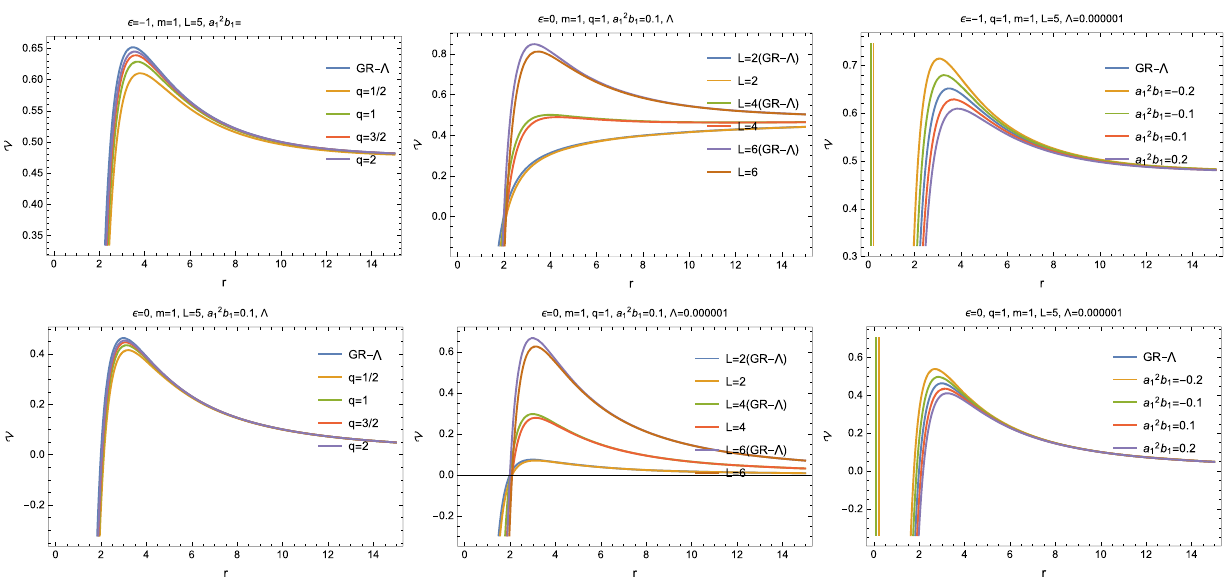
Fig. 1 The upper and lower plots are denoting the potential V for some typical values of the parameters for the massive and massless particles,